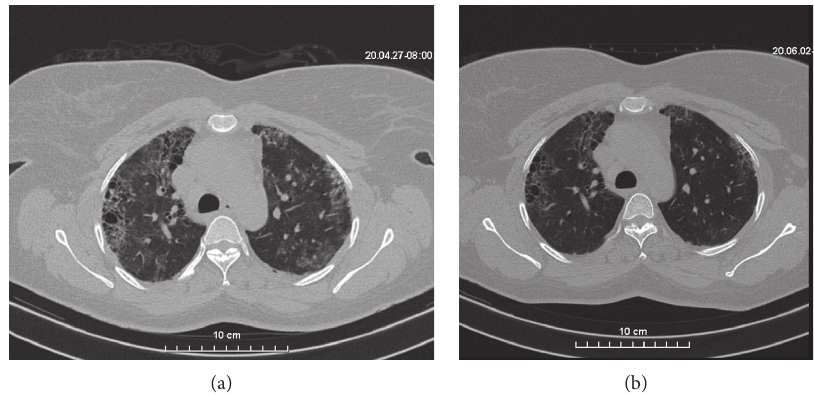
Figure 1: (a) Chest computed tomography (CT) scans (transverse plane) of the patient 1: frosted glass area extended central and bilateral upper lobar peripheral and fibrosis. (b) Chest computerized tomography (CT) scans (transverse plane) control of the patient 1: good evolution with almost disappearance of the frosted glass